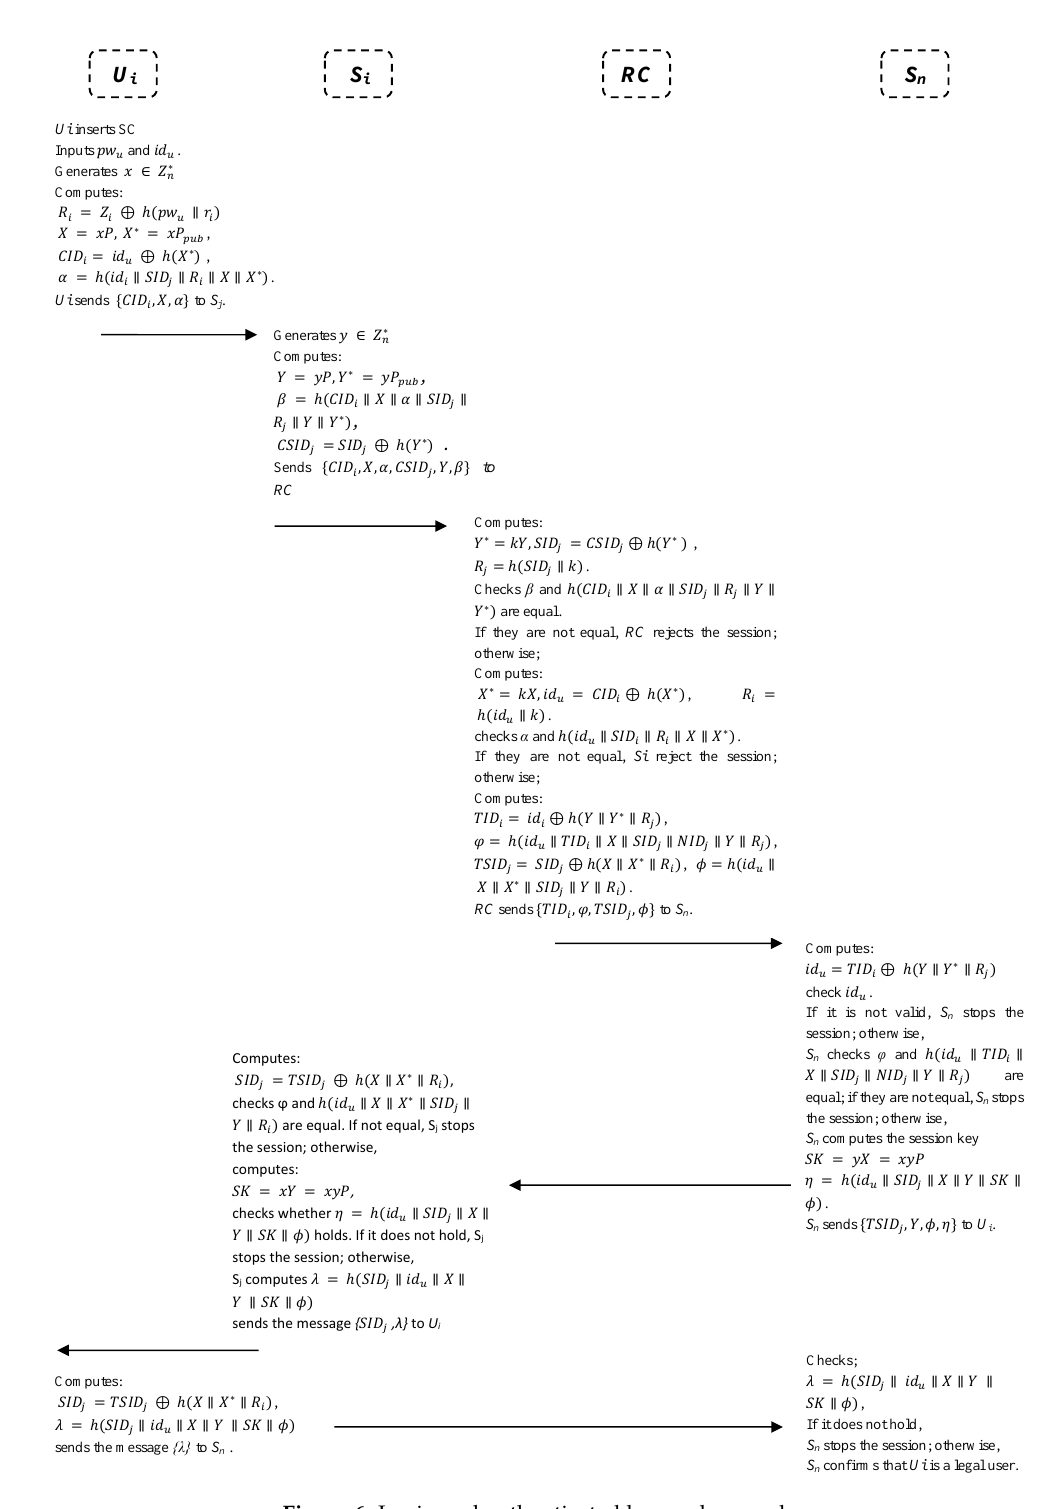
Figure 6. Login and authenticated key exchange